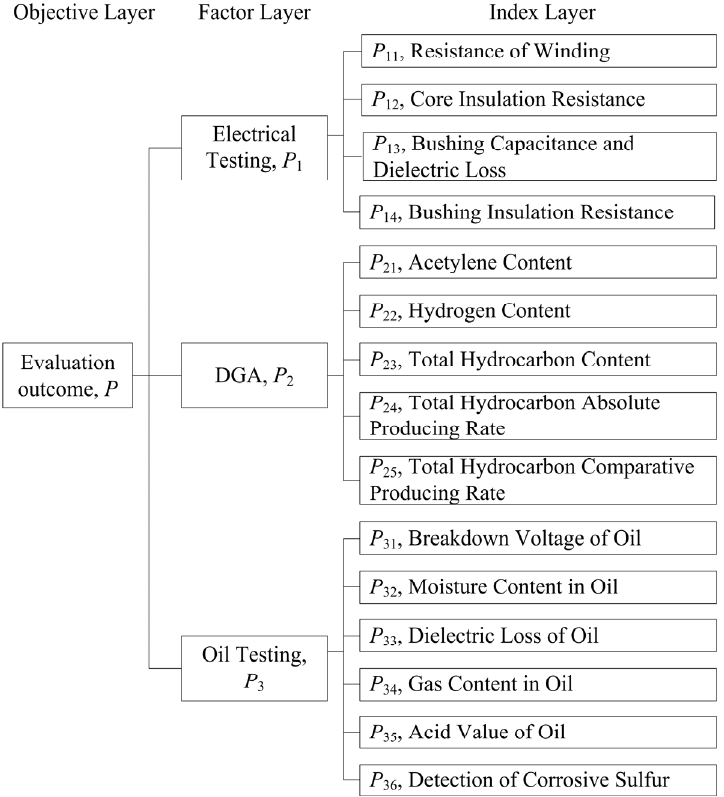
Figure 1. Level 1 assessment index